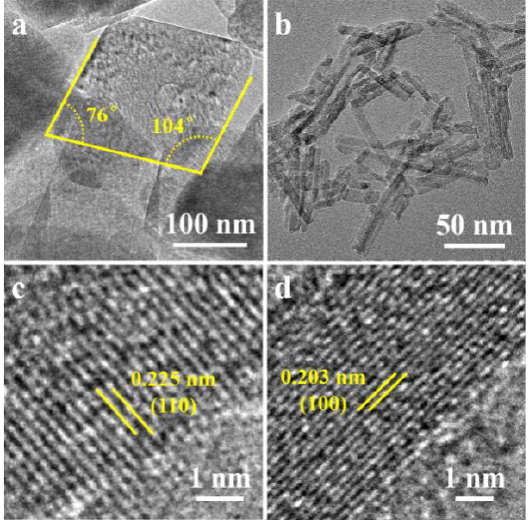
Figure 3. High-resolution TEM images of synthesized γ -Al 2 O 3 . ( a , c ) Al-NF and ( b , d ) Al-NW.